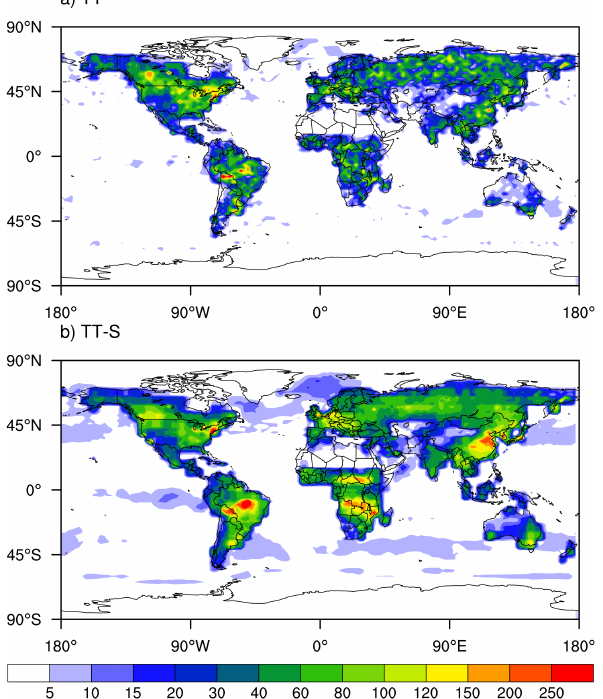
Figure 11. Same as Fig. 10 but for CO 2 concentrations (units are